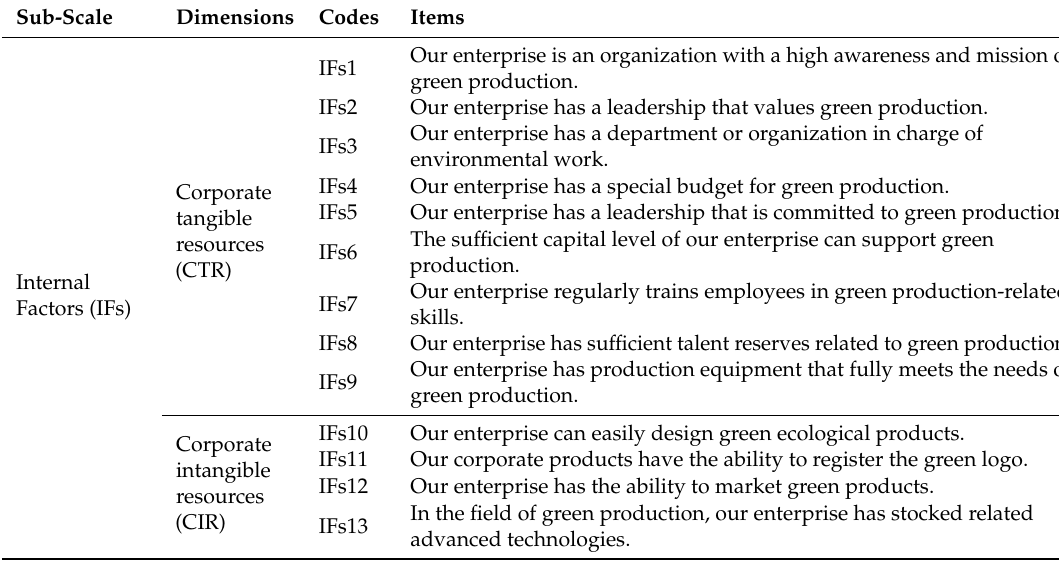
Table A1. Questionnaire items on the green development behavior and performance of industrial enterprises